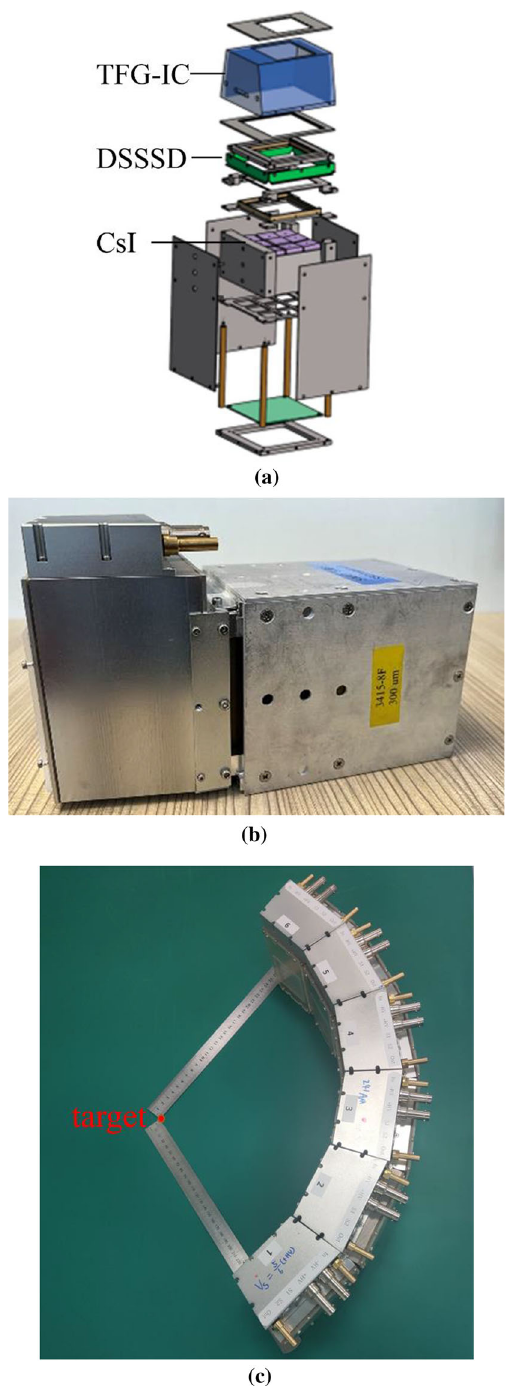
Fig. 1 Diagram and photos of a detector unit with TFG-IC as the tele- scope arrays: exploded diagram of the TFG-IC-based charged-particle telescope ( a ), side-view photo of the telescope ( b ) and photo of the TFG-IC array ( c ). The red dot ( c ) is the position of the reaction target in the beam